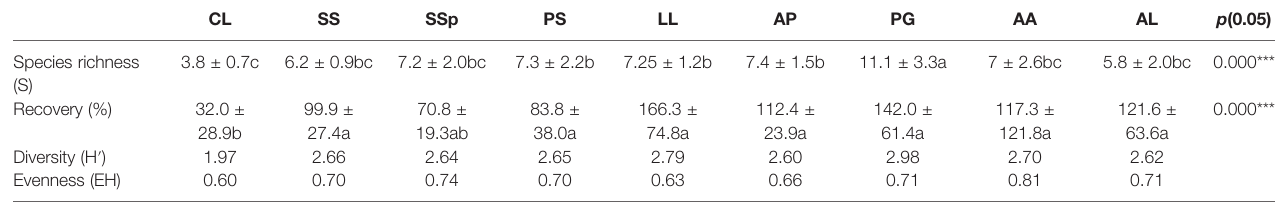
TABLE 2 | Diversity of spontaneous species around planted woody species (CL, C. lusitanica; SS, S. siamea; SSp, S. spectabilis; PS, P. sylvestris; LL, L. leucocephala; AP, A. polyacantha; PG, P. guajava; AA, A. auriculiformis; AL, A. lebbeck).